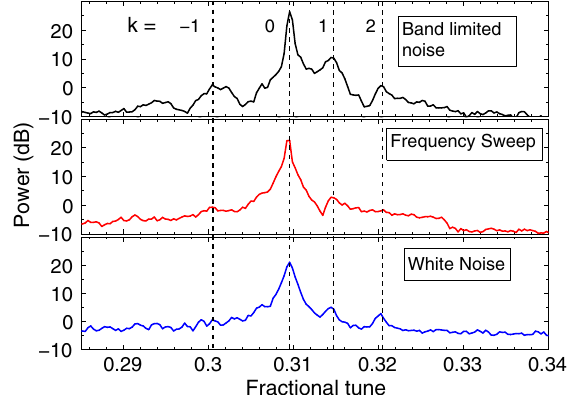
FIG. 20. Transverse center of mass along the bunch for k ¼ 0 , 1, and 2 modes corresponding to Fig. 19. The data shown is for 11 consecutive turns. Frequency sweep is used to excite the beam which enables to resolve the distinct head-tail modes temporally. The rms bunch length ( 2 (cid:10) rms ) is